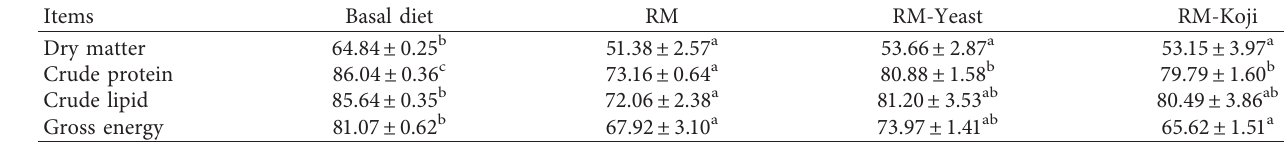
Table 3: Nutrients and gross energy contents (%) of the basal and tested